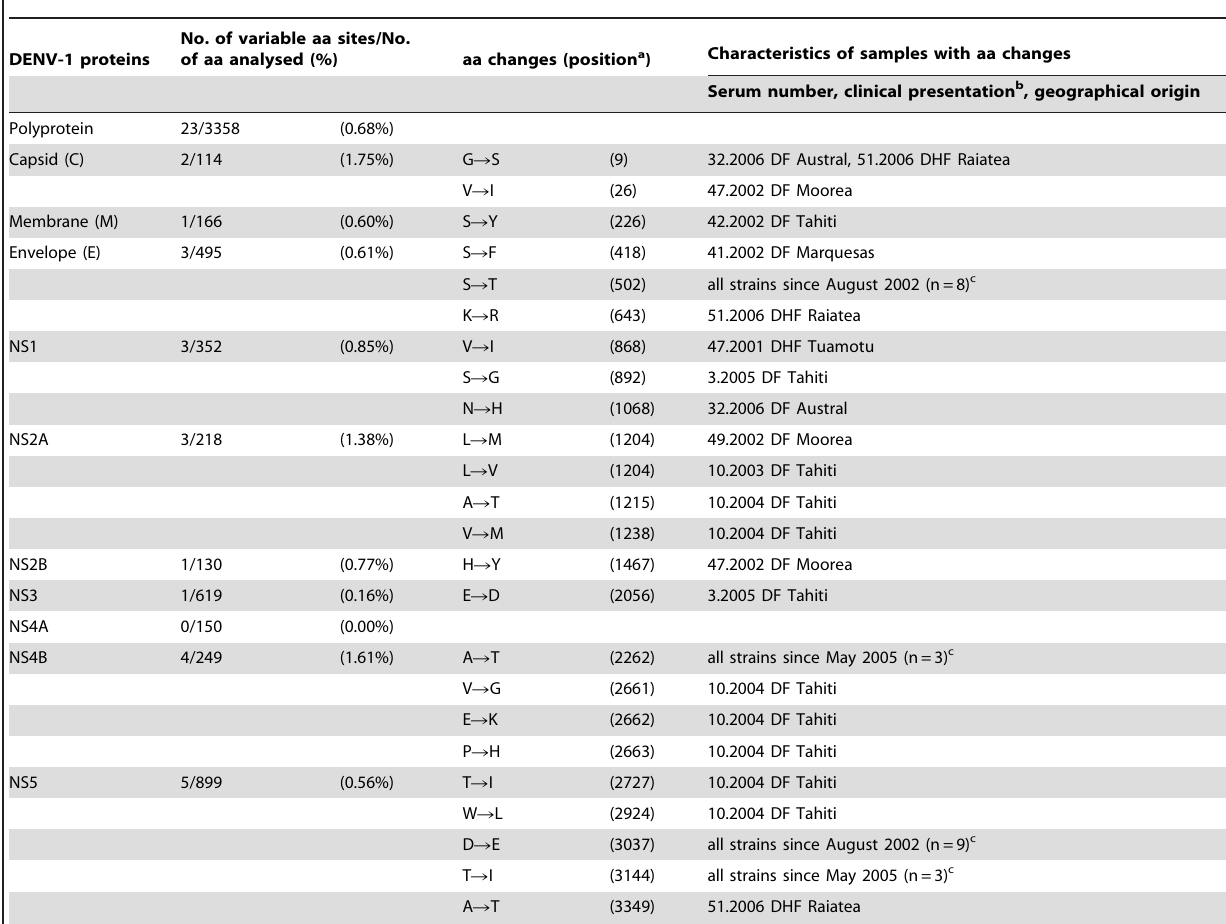
Table 2. Analysis of polyprotein sequences of 12 DENV-1 viruses recovered in FP between 2001 and 2006.